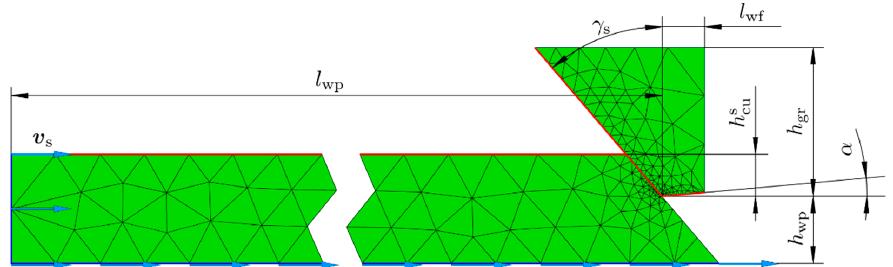
Figure 5. Schematic representation of the boundary value problem for the single grain simulations. The coarse initial mesh is adaptively refined during the simulation. Graphic taken from [15] with